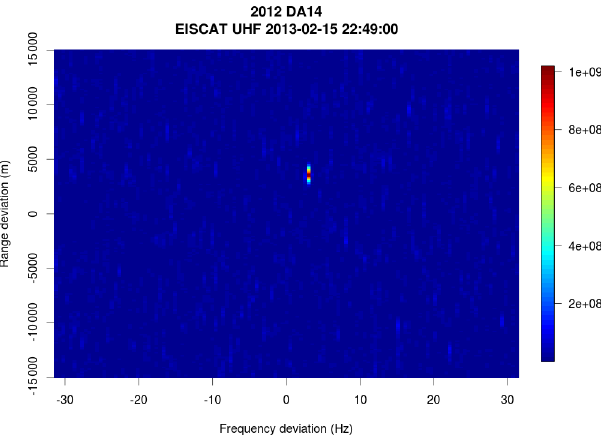
Figure 1. Range–Doppler intensity radar image of asteroid 2012 DA 14 observed using EISCAT UHF near the closest approach on 15 February 2013. The Doppler width and range extent are lim- ited due to the low frequency and limited range resolution (150m). No range or Doppler width information, apart from object aver- age range and average Doppler, is obtained. NEO observations with E3D are expected to be of a similar nature, with a factor of 4 times less Doppler resolution due to wavelength but a factor of 5 more range resolution due to a higher transmission